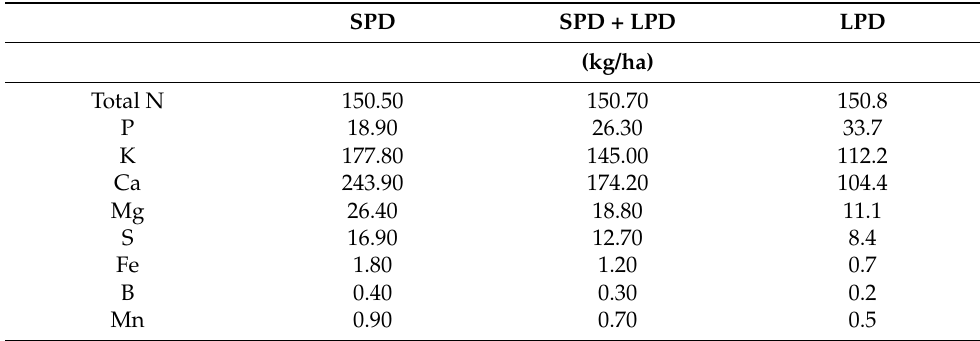
Table 5. Specifications of the applied SPD, SPD + LPD and LPD in relation to the application of nutrients per hectare of soil.